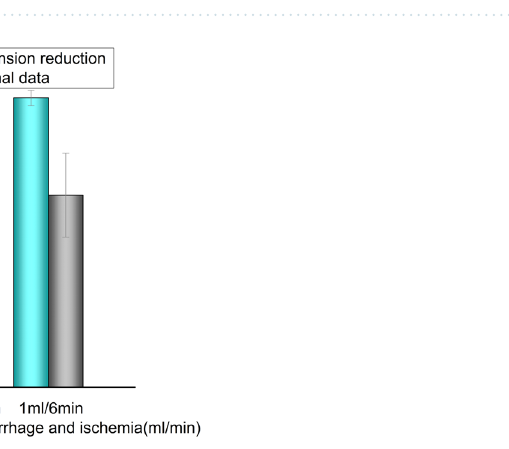
Figure 4. The RSEDs from single-channel measurements and 16-channel measurement in cerebral hemorrhage and cerebral ischemia (No. 4 and No. 6, 1.2 GHz). ( a ) The RSEDs from single-channel measurements (channel 1-1). ( b ) The RSEDs from the 16-channel measurement.